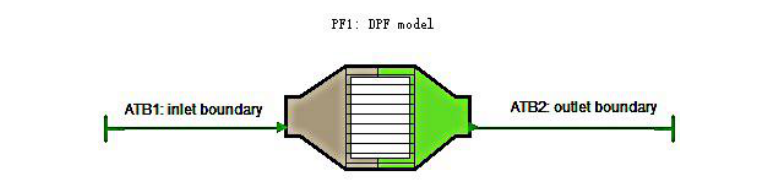
Fig. 3. One-dimensional simulation model of DPF.